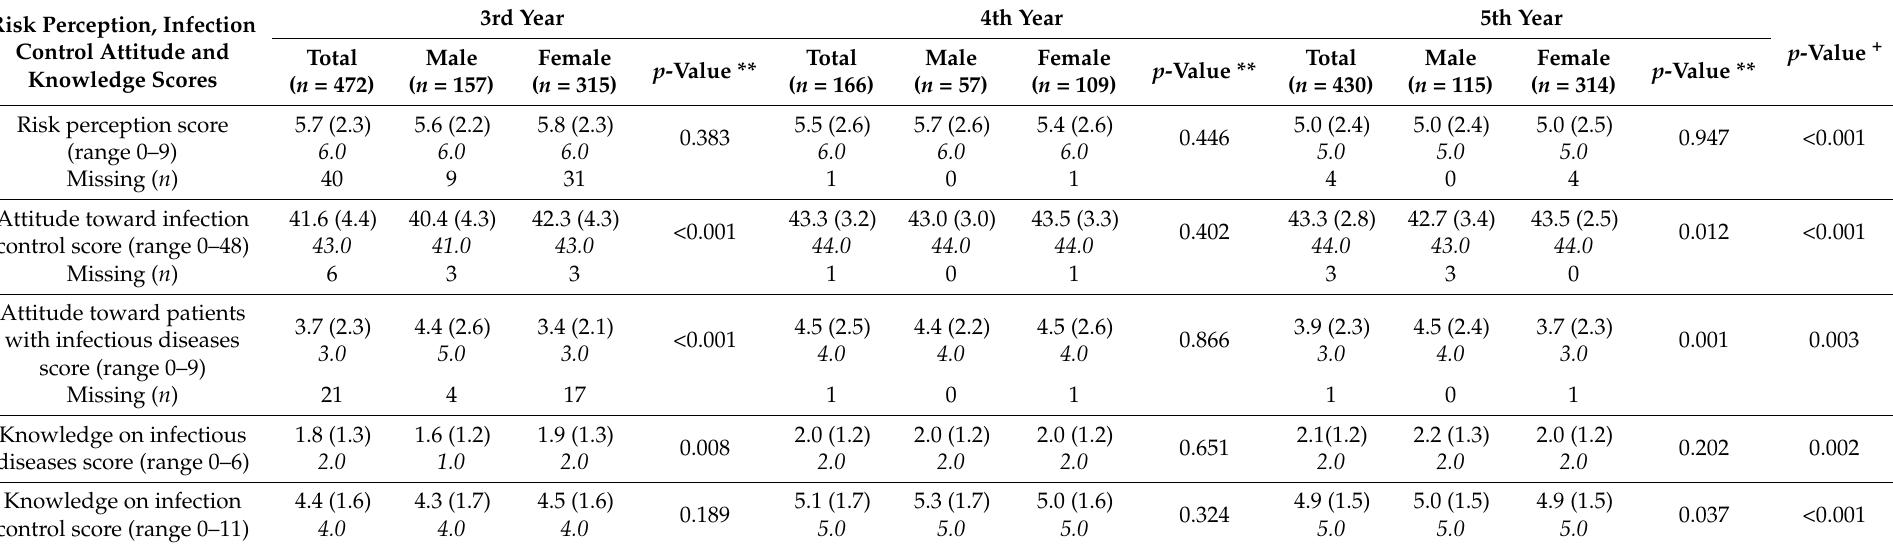
Table 2. Scores for risk perception, knowledge, and attitude toward infectious diseases and their control among the third-, fourth-, and fifth-year students in four Egyptian public dental